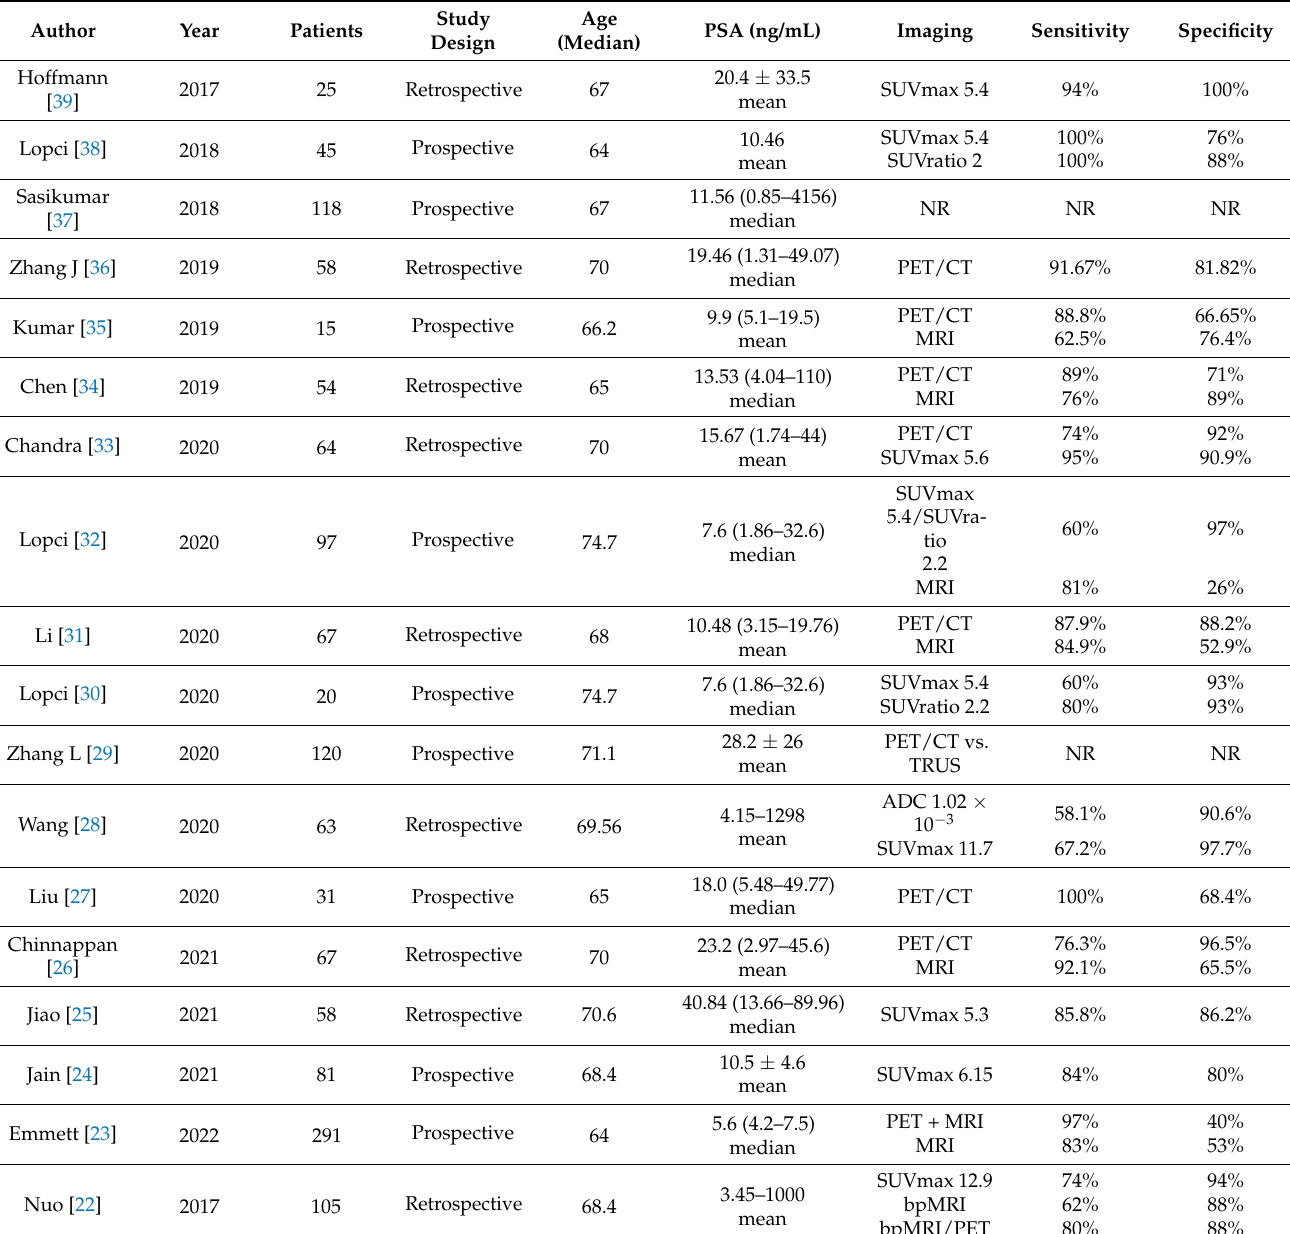
Table 1. Summary of patients’ characteristics and diagnostic performance of different imaging modalities, including PSMA